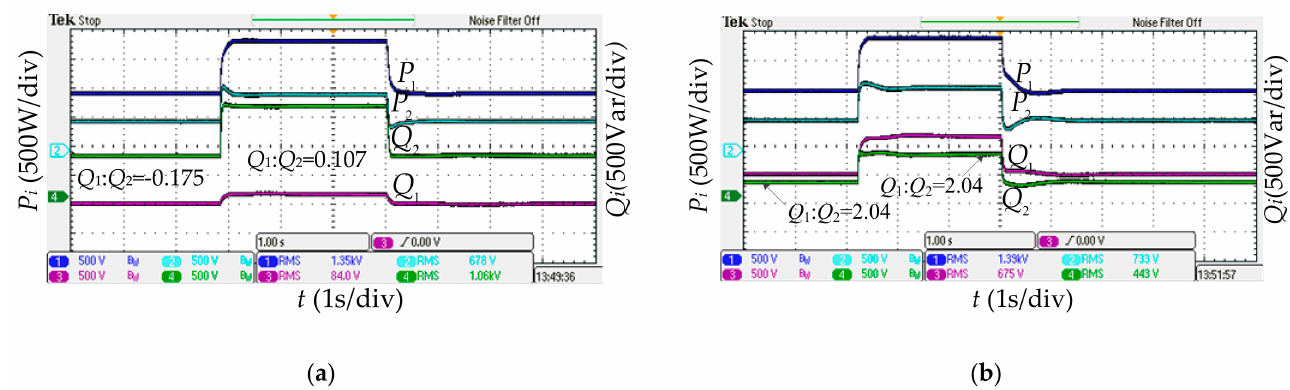
Figure 10. Waveforms of experimental results using different control strategies in experimental condition 2. ( a ) The traditional VSG control strategy outputs power waveform. ( b ) The integrated control strategy presented in this study outputs power waveform. Table 6. Steady-state values of reactive power with different capacities. Control